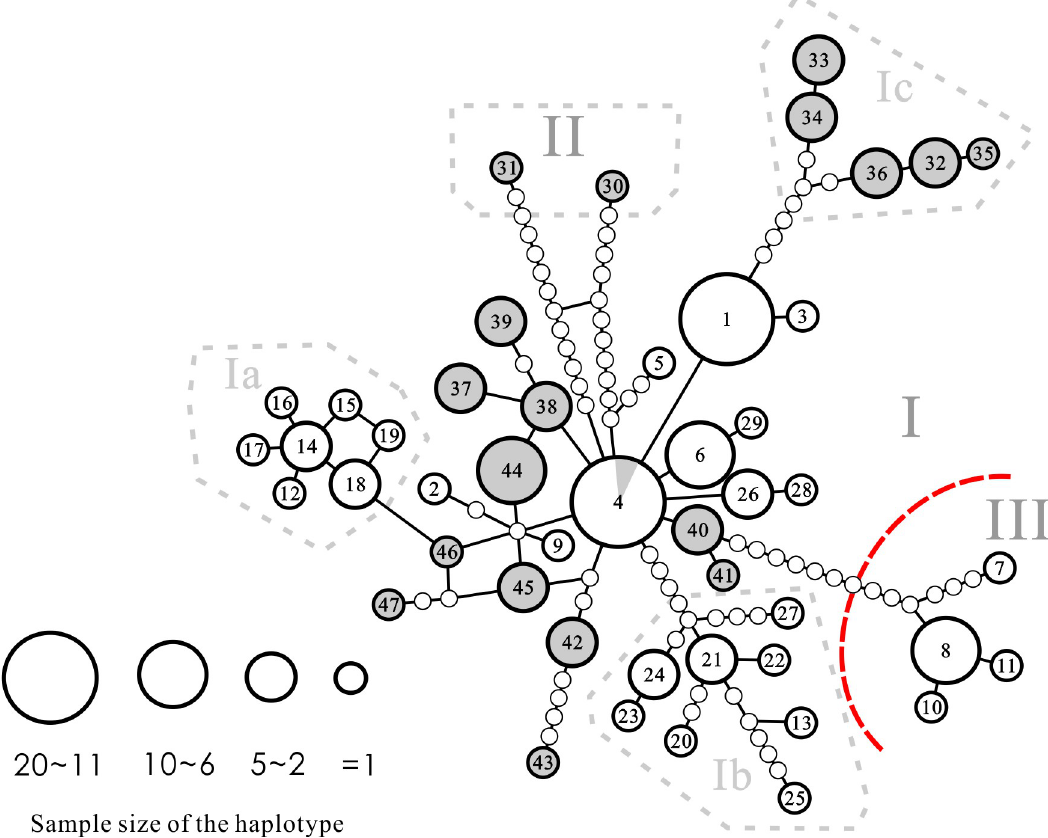
Fig 4. Statistical parsimony haplotype network for haplotypes constructed by TCS 1.21. Numbers inside circles are haplotype codes. Circle size reflects the number of individuals having the corresponding haplotype. Small solid dots signify possible missing haplotypes. A line connecting two haplotypes represents one nucleotide substitution. White circles: haplotypes collected from Hainan Island; grey circles: haplotypes collected from southern mainland China. The red broken line separates the two major clusters in this